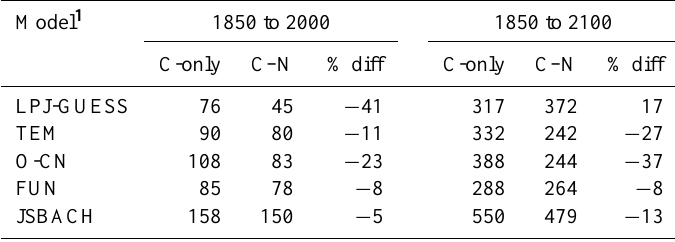
Table 1. Modelled C sequestration [PgC] for periods 1850 to 2000 and 1850 to 2100 with LPJ-GUESS and four additional C–N models with % difference between C-only and C–N